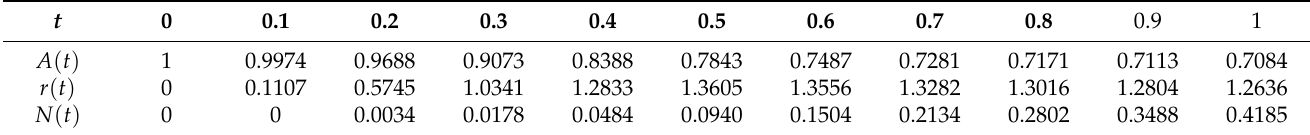
Table 1. Performance measures in transient regime for K = 3.